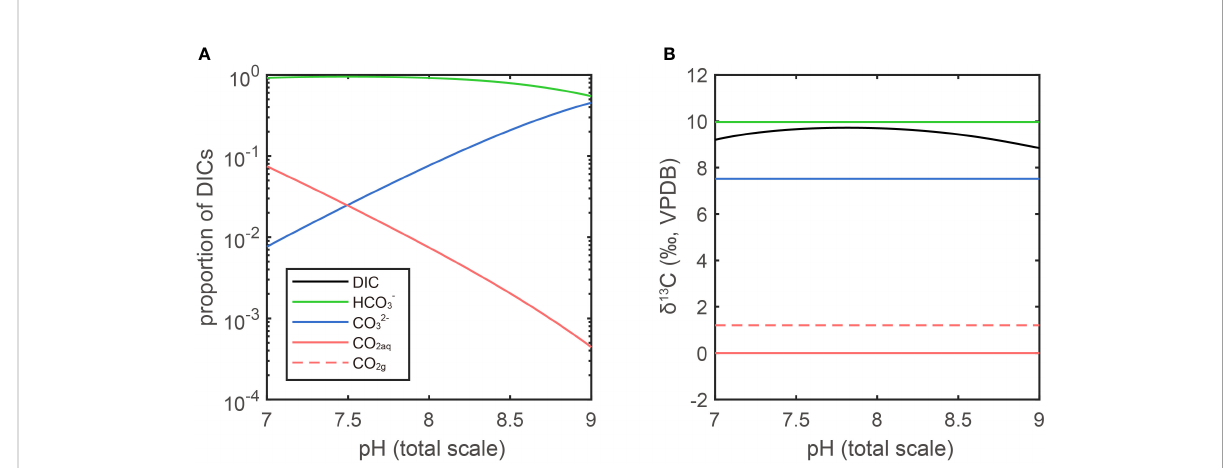
FIGURE 2 DIC proportion and isotope fractionation in different pH. (A) The ratio of the three components of DIC are plotted on a log scale in function of pH for a seawater at T = 291.15K and Salinity = 35 ‰ . (B) The isotopic fractionations are calculated by the parameters in Table A1. The d 13 C VPDB of CO 2 (aq) is arbitrarily set as 0 ‰ (red line). In isotopic equilibrium, the CO 2 (g) is heavier than CO 2 (aq) by 1.2 ‰ , the HCO 3- is heavier than CO 2 (aq) by 9.8 ‰ and CO 32- is heavier than CO 2 (aq) by 7.4 ‰ (Zhang et al., 1995). The fractionation between total DIC and CO 2 (aq) is a function of pH as it determines the proportion of each